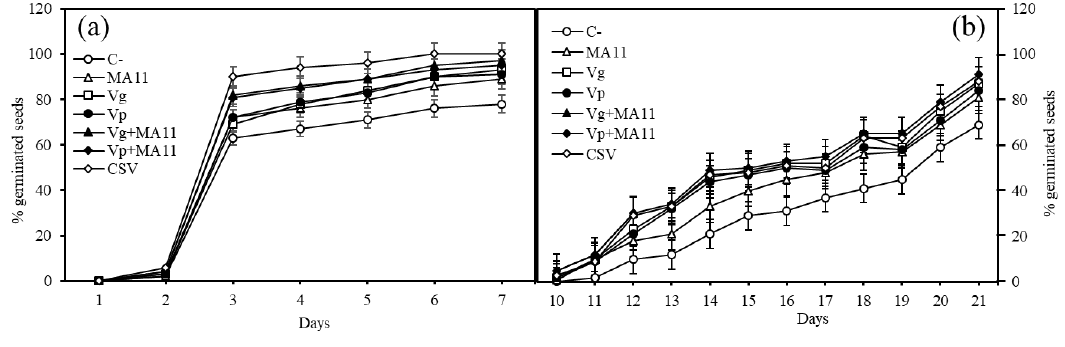
Figure 1. Percentage of germinated seeds. ( a ) Germination without metals and ( b ) germination with metals. Values are means ± S.D. ( n = 50). C–: non inoculation; MA11: inoculation with Ensifer medicae MA11; Vg: inoculation with Variovorax gossypii JM-310 T ; Vp: inoculation with V. paradoxus S110 T ; Vg + MA11: co-inoculation with V. gossypii JM-310 T and E. medicae MA11; Vp + MA11: co-inoculation with V. paradoxus S110 T and E. medicae MA11; CSV: inoculation with V. gossypii JM-310 T , V. paradoxus S110 T and E. medicae MA11.